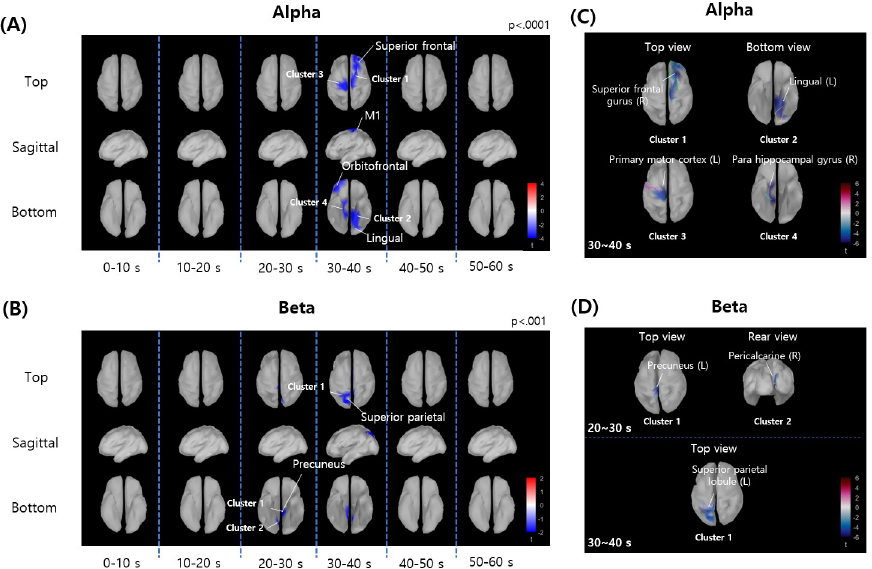
Fig 4. The distribution of t-values over cortical surface at successive 10 s intervals. The t-scores within the clusters showing significant difference between high and low arousal conditions were shown by color-codes for (A) alpha-band and (B) beta-band. In total, eight significant clusters were found. More detailed views of the seven significant clusters are depicted in (C) alpha-band and (D) beta-band, respectively.